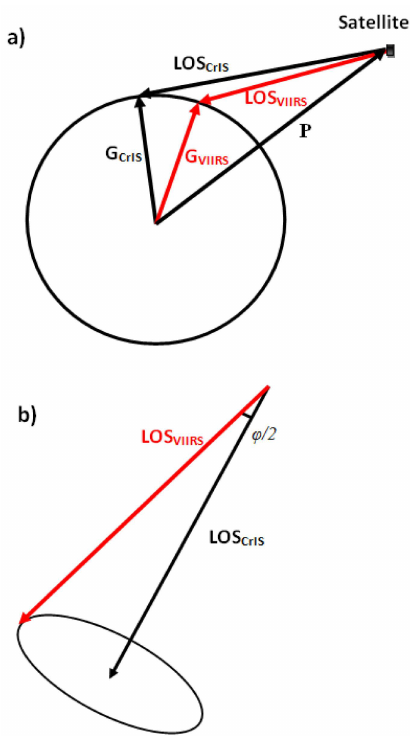
Figure 5. Schematic diagrams showing how to collocate VIIRS pixels CrIS FOV through VIIRS and CrIS LOS pointing vector, including ( a ) computation of the VIIRS and CrIS LOS vectors in ECEF and ( b ) examination of the angle between CrIS and VIIRS LOS vectors. Note that ϕ is the CrIS detector FOV angle of 0.963 ◦